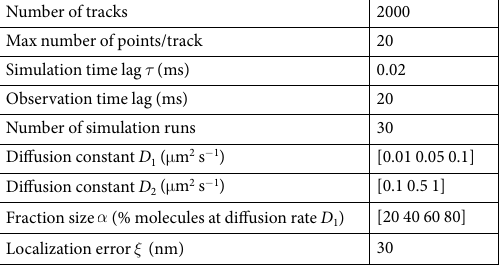
Table 1. Configuration of the synthetic trajectories.